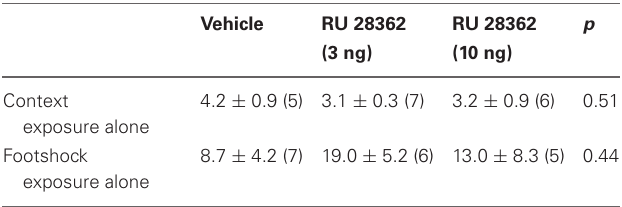
Table 1 | Effect of RU 28362 after context or footshock exposure